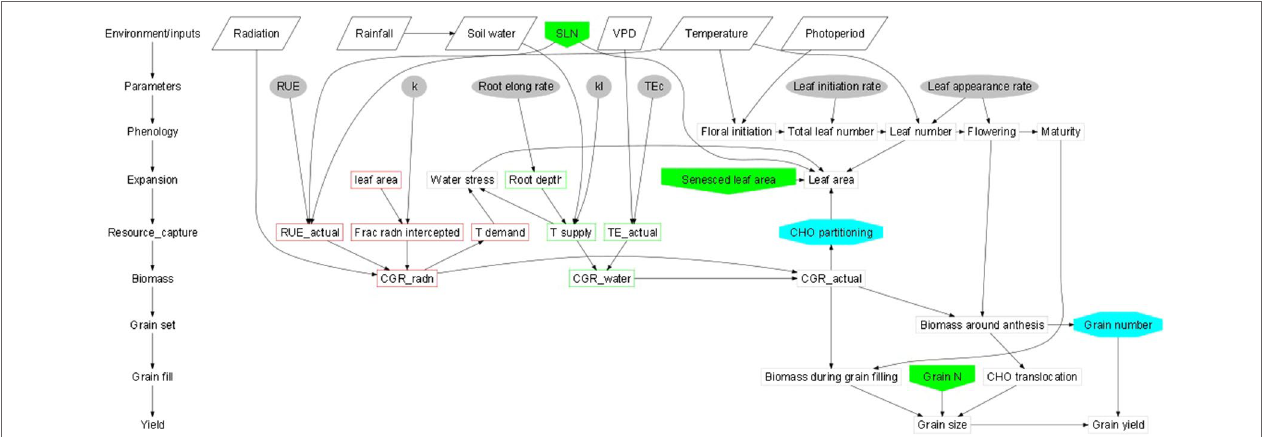
FIGURE 1 | Schematic representations of crop growth and development dynamics (Generic template; Connections between the two schematics are shown by the shaded boxes); [Hammer et al., 2010: